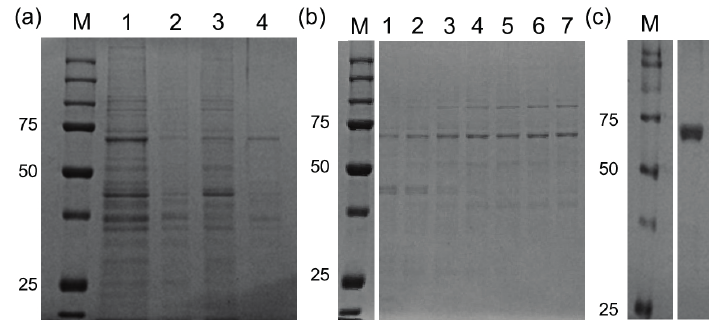
Figure 3. Purification of TGR from M. vogae tetrathyridium larvae. ( a ) Ammonium sulfate precipitation of a total aqueous extract from tetrathyridium larvae was carried out in three steps (0%–25%, 25%–50% and 50%–85% ammonium sulfate saturation) and analyzed by SDS-PAGE under reducing conditions (lane 1 corresponds to the total extract, lanes 2, 3 and 4 to 0%–25%, 25%–50% and 50%–85% ammonium sulfate saturation fractions, respectively); ( b ) The 25%–50% ammonium sulfate saturation fraction was further purified by size exclusion chromatography (SEC) on a 16/600 Superdex 200 column; lanes 1 to 7 show fractions were the TR and GR activities eluted; ( c ) SEC fractions containing TR and GR activities were pooled and subjected to a anionic chromatography on a MonoQ column. Bound proteins were eluted using a NaCl 10–1000 mM gradient and the fractions obtained were analyzed by SDS-PAGE under reducing conditions. The lane shown corresponds to the fraction with maximal TR and GR activity, which eluted at NaCl 300 mM. The gels shown in ( a , b ) were coomassie stained and the gel shown in ( c ) was silver stained. M denotes molecular weight